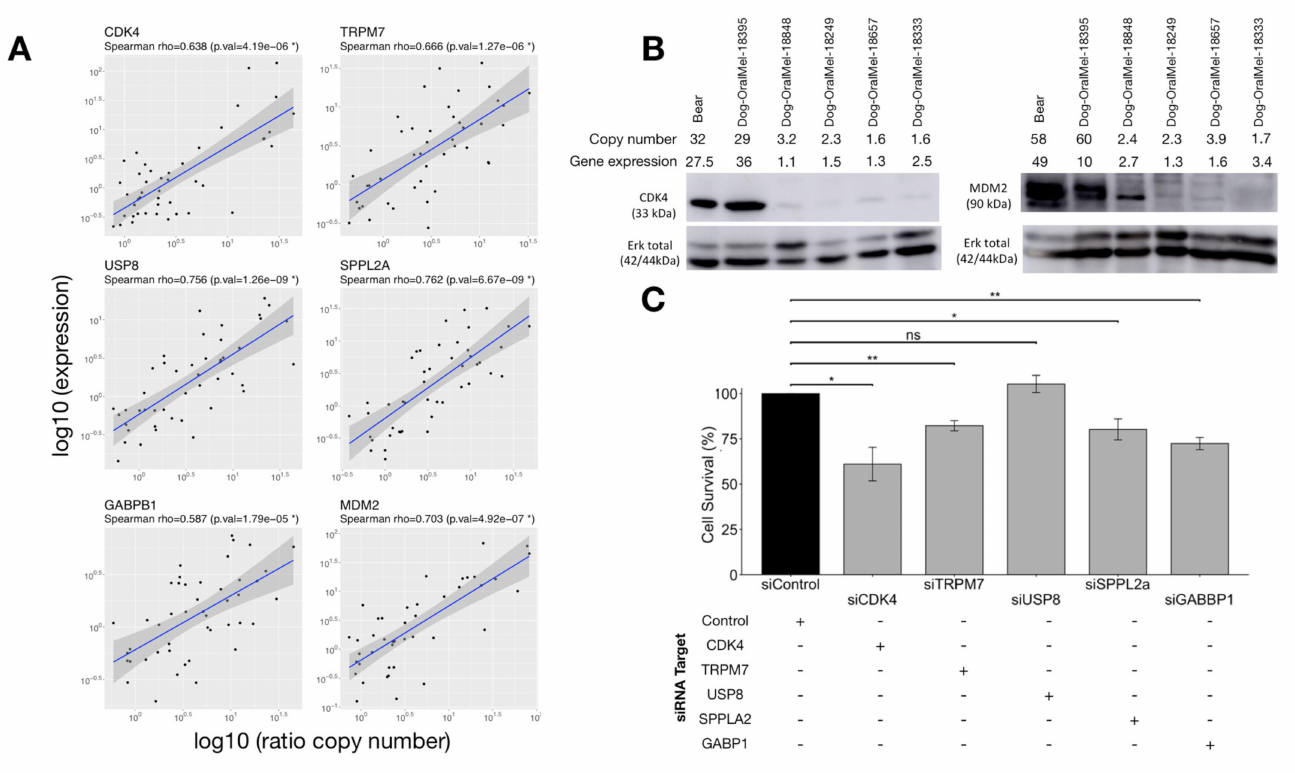
Figure 3. Expression data of the CFA 10 and CFA30 candidate genes at mRNA and protein levels and impact on cell proliferation. ( A ). For the CFA 10 genes (MDM2, CDK4) and CFA 30 genes (GABPB1, TRPM7, SPPL2A and USP8), expression was defined by RT-qPCR and was significantly correlated to copy number in tumor tissue ( n = 46). ( B ). Western blot analysis in six canine MM cell lines showing a higher amount of protein in cell lines having high copy numbers of CDK4 and MDM2. ( C ). Cell proliferation assay (Bear cell line) showing the effect of the knockdown (siRNA) of candidate oncogenes from CFA 30 and CDK4 on cell survival. The knockdown of CDK4, TRPM7, GABPB1, and SPPL2A had an impact on cell proliferation in comparison with the control siRNA ( t -test, with * corresponding to p -values <0.05 and ** to p -values